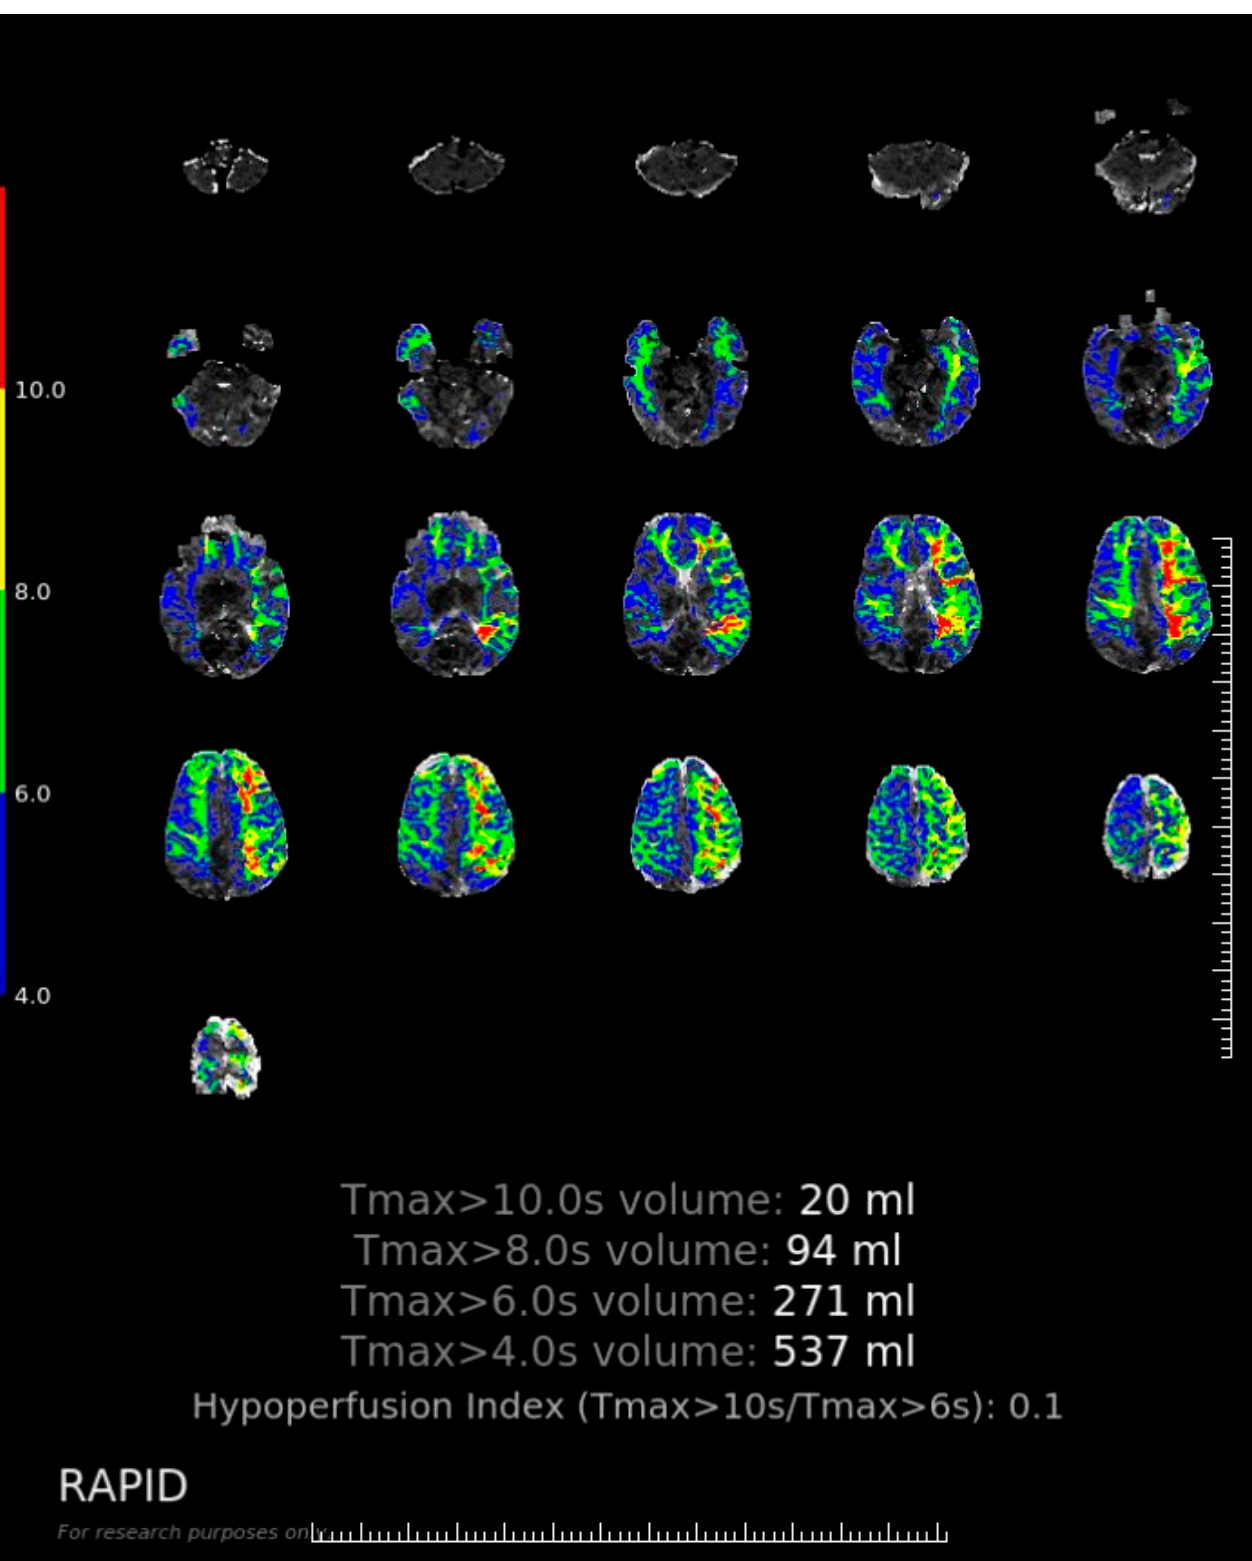
Figure A2. The hypoperfused area calculated by the Tmax map. Step 3: Calculating the mismatch.